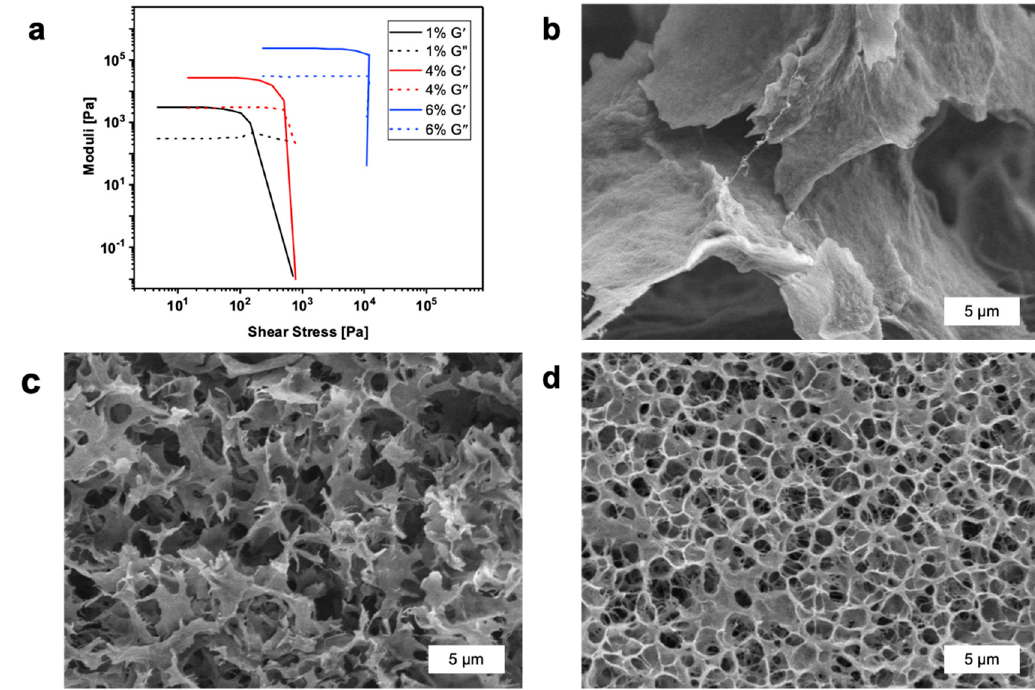
Figure 2. ( a ) Rheology curves of SF hydrogels at the [SF] values of 1 wt% (black), 4 wt% (red), and 6 wt%(blue). SEM images of lyophilized SF hydrogels by using 1 wt% ( b ), 4 wt% ( c ), and 6 wt% ( d ) monomeric solutions.